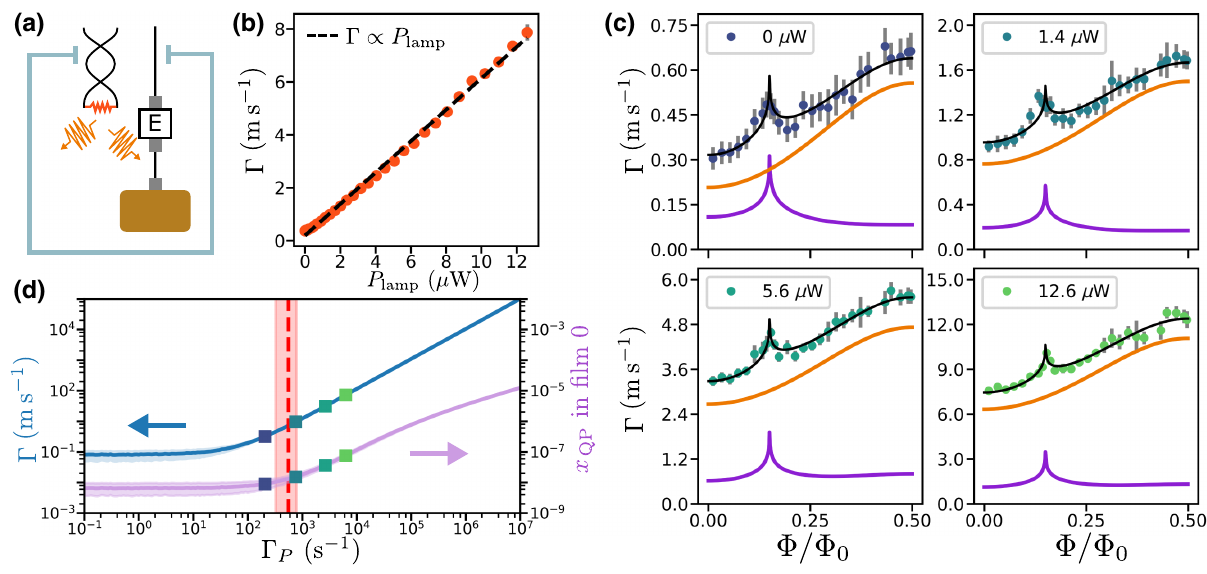
FIG. 4. (a) The manganin “lamp” resistor hangs in the aluminum can shielding the copper cavity containing the qubit. The coax lines include a high-frequency-absorbing Eccosorb CR-110 filter (“E”) in line just before the readout cavity, inside the can. The passing of current through the lamp causes its temperature to rise, resulting in additional radiation that can leak into the cavity and induce PAPS. Photons may enter the electromagnetic environment of the qubit through SMA connectors or packaging seams. (b) (cid:4) as a function of the power dissipated by the manganin “lamp” resistor, measured at (cid:5)/(cid:5) 0 = 0. (cid:4) increases approximately linearly with the power dissipated by the lamp (black dashed; for discussion, see Appendix F). (c) (cid:4)((cid:5)) measured at P lamp = { 0, 1.4, 5.6, 12.6 } μ W. We perform a simultaneous fit to all four data sets allowing unique f P and ¯ n and shared s , g other , and δ(cid:2) (solid black). The contributions of PAPS (orange) and NUPS (purple) indicate that as the lamp power increases, both types of parity switching increase. (d) The simulated (cid:4) (cid:4)( 0 ) (blue, left axis) and x 0 (lavender, right axis) as a function of P , calculated using fit values from Fig. 4(c). Experimental values (squares) are marked for reference and the PAPS level at which g P = g other is marked by the red dashed line. The reduction of (cid:4) P beyond the current background level ( P lamp = 0) would reduce (cid:4) and x QP but the improvement is limited due to g other , which is comparable to g P